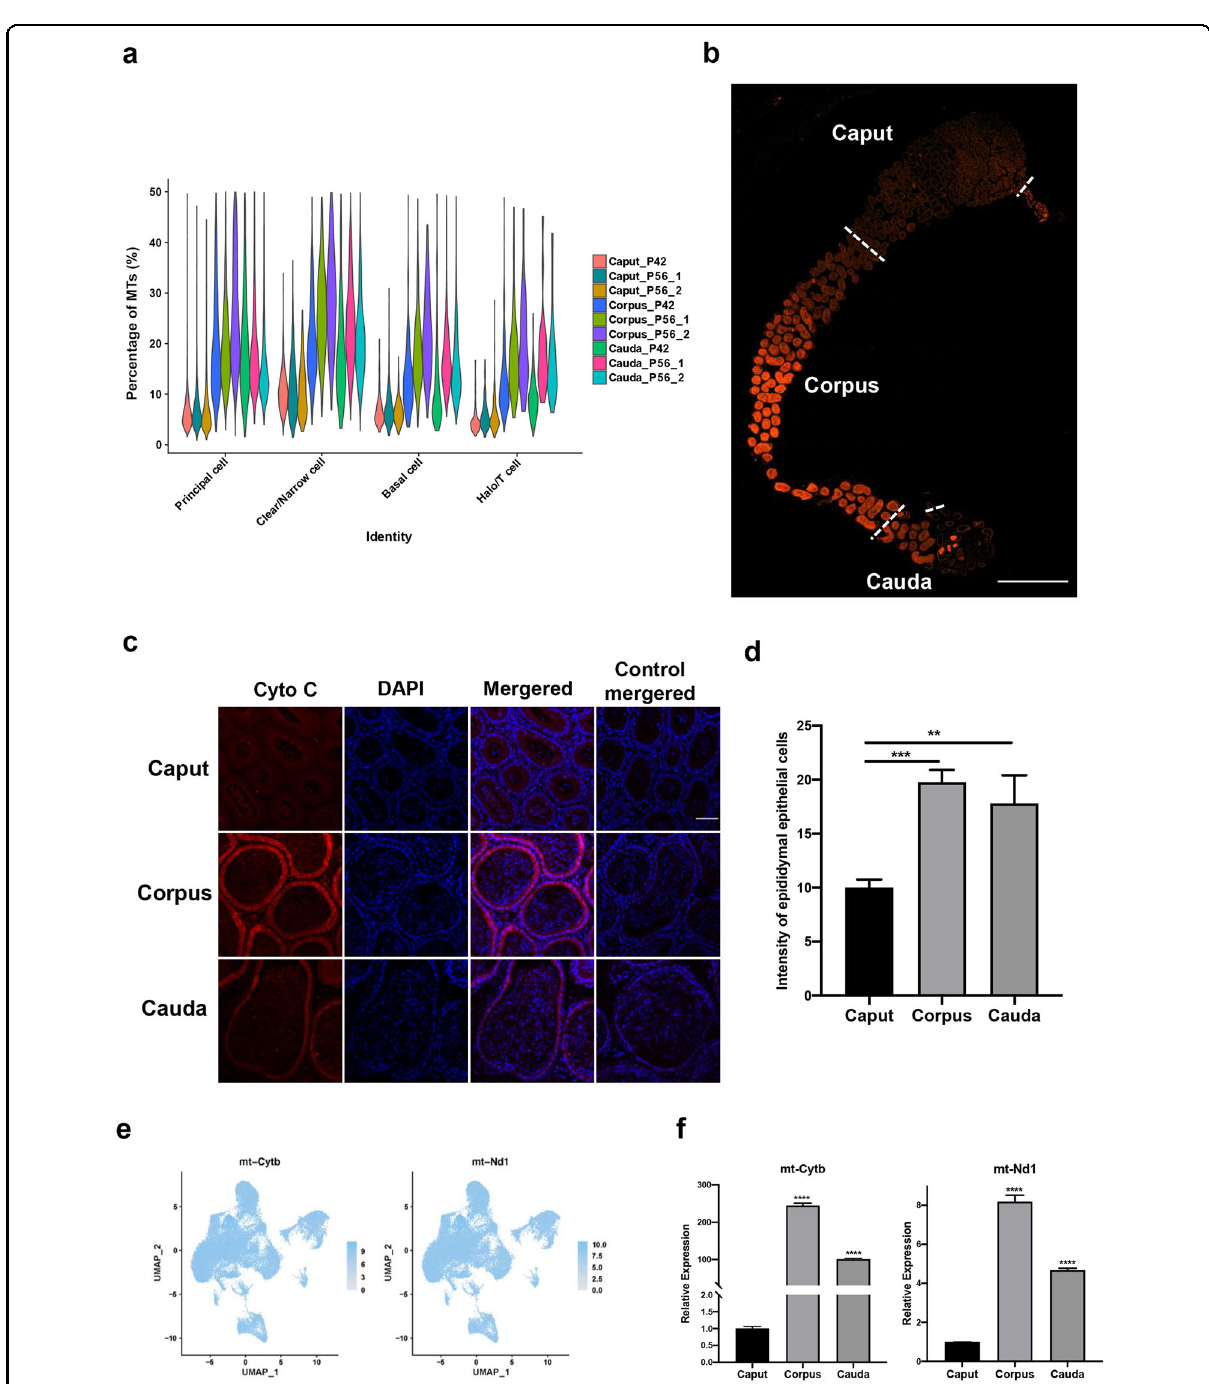
Fig. 4 Characterization of the mitochondrial distribution in epididymal regions. a The segmental percentage of mitochondrial transcripts (MTs) in epididymal epithelial cell clusters. b Stitched image of immunostaining of the mitochondrial marker cytochrome c in the mouse epididymis. Scale bar = 1 mm. c Representative images of cytochrome c staining in the caput, corpus and cauda epididymis. Scale bar = 50 µm. Red: cytochrome c (cyto C), Blue: DAPI for nuclear count staining. d Corresponding statistics of cytochrome c staining in the segmental epididymis. ** P < 0.01; *** P < 0.001. e UMAP plots of mitochondrial transcript genes (mt-cytb and mt-Nd1) in the indicated cell clusters (color values were log1pRPM). f Representative mitochondrial transcript genes (mt-cytb and mt-Nd1) in sperm-depleted epididymal segments by qPCR analysis. The statistical signi fi cance was corpus or cauda vs. caput. **** P <